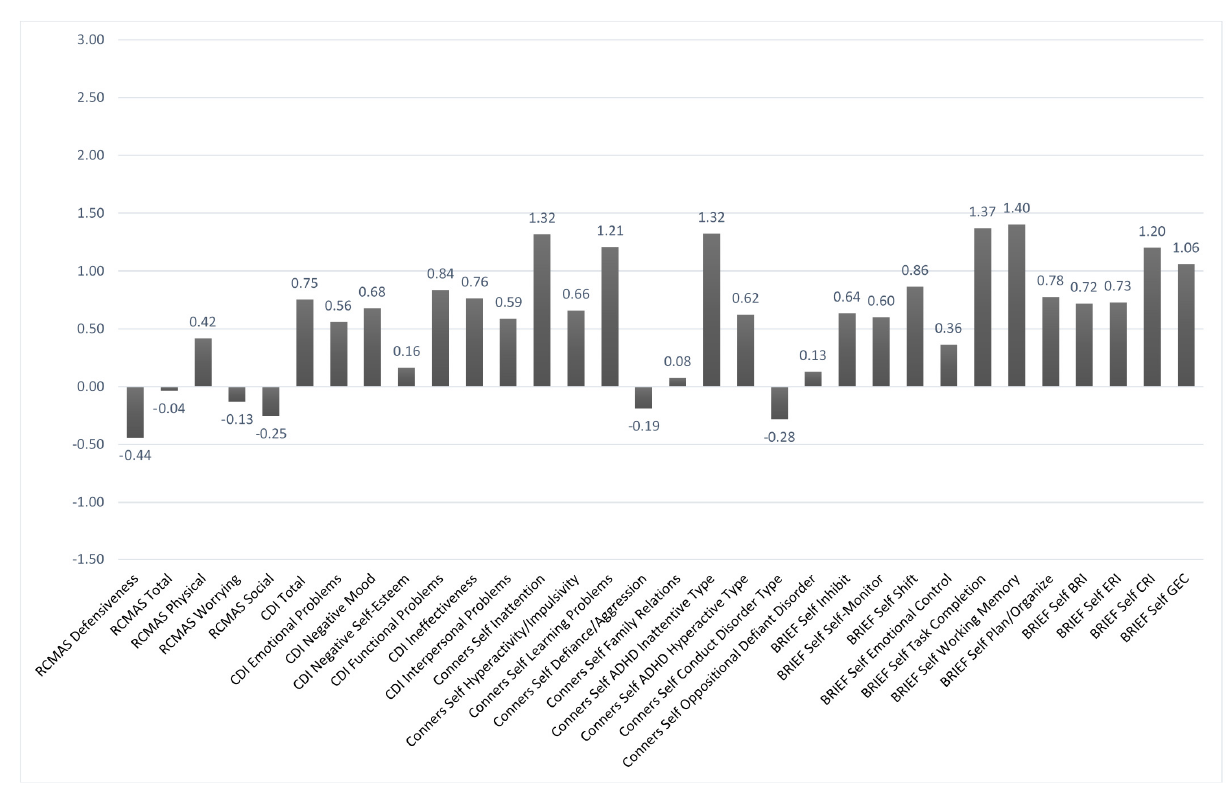
Figure 1. Performance Baseline Data. n = 17. The y-axis is based on z -scores (M = 0, SD = +/- 1). Lower scores indicate poorer performance. Weschler Intelligence Scale for Children-5 th ed. (WISC-V); Wisconsin Card Sorting Test (WCST); Conner’s Continuous Performance Test (CPT); Woodcock Johnson Test of Achievement-IV (WJ-IV); Wide Range Assessment of Memory and Learning (WRAML).